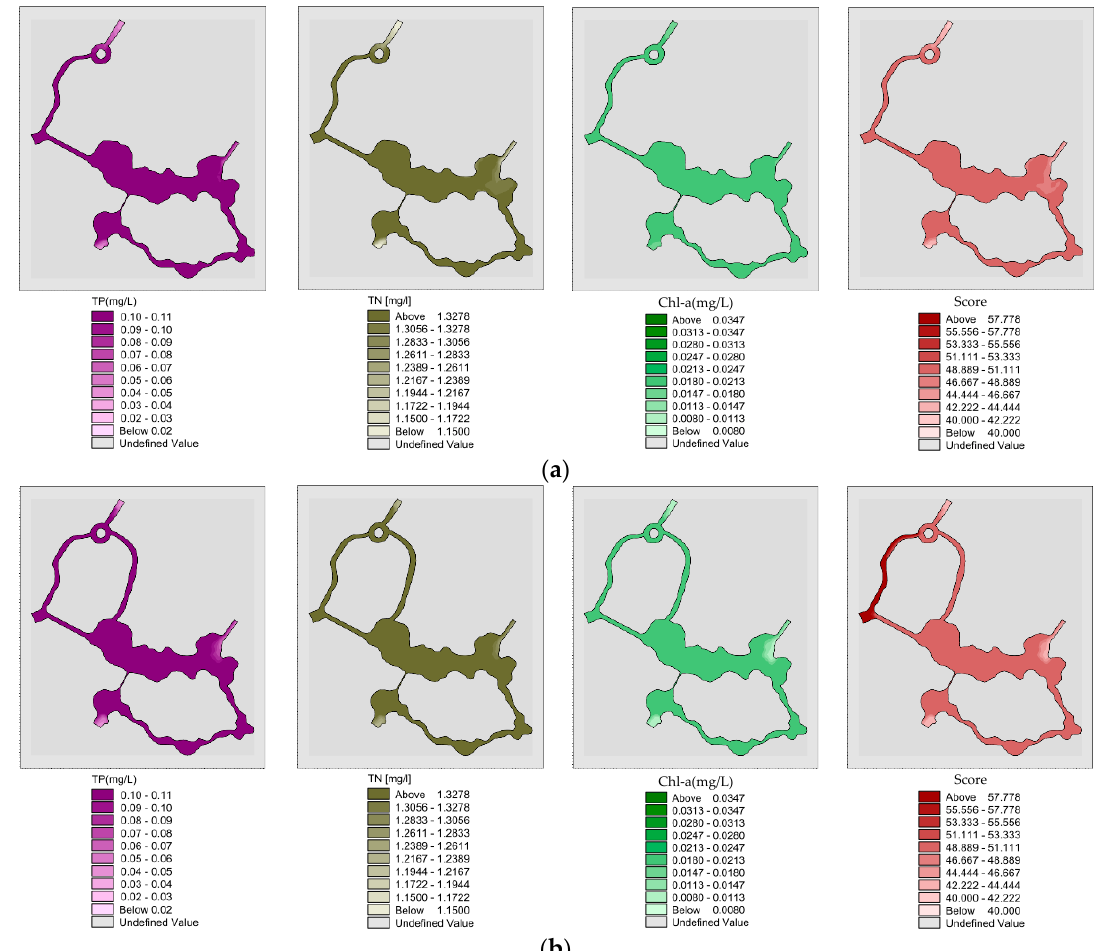
Figure 18. ( a ) Spatial distribution of “unilateral” river TP, TN, Chl-a and eutrophication scores without water diversion in winter; ( b ) Spatial distribution of “bilateral” river TP, TN, Chl-a and eutrophication comprehensive scores in winter without water diversion.